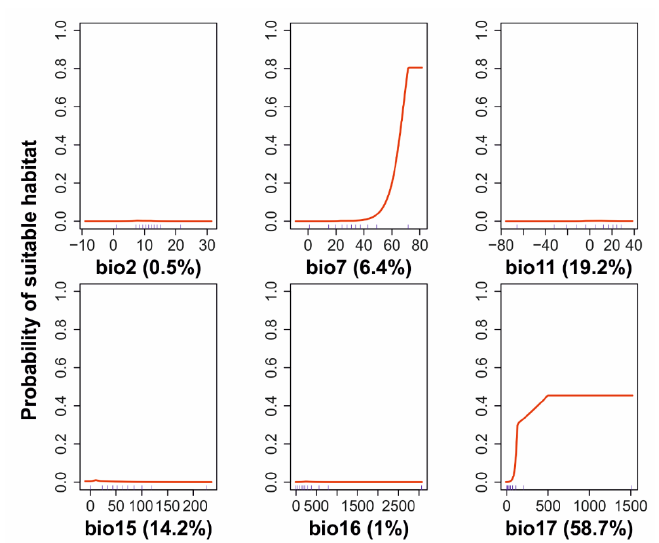
Figure 2. Response curves present how predicted niche suitability for Gnathotrichus materiarius changed along particular predictor gradients. Numbers in parentheses indicate the relative importance of variables. Variable importance, i.e., the proportion of variation, explained by particular variable based on AUC [113] gain for a single feature.